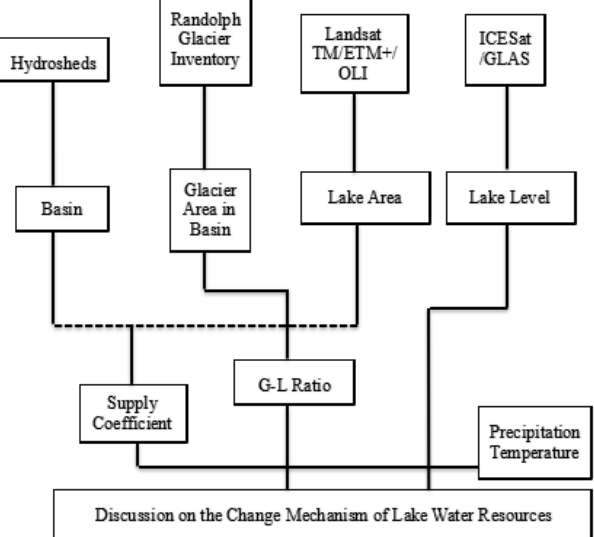
Figure 1. Technology roadmap.